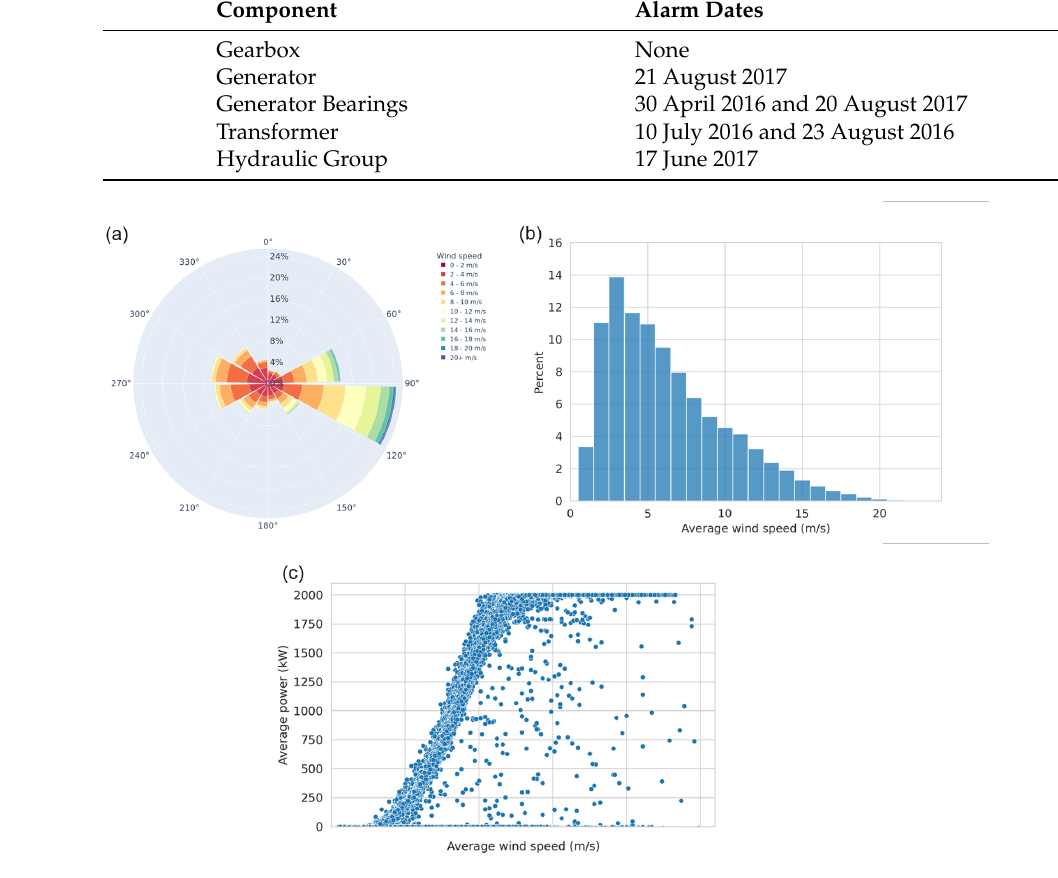
Figure 2. Measurement data for WT07: ( a ) wind rose; ( b ) wind speed frequency distribution; ( c ) power curve (without